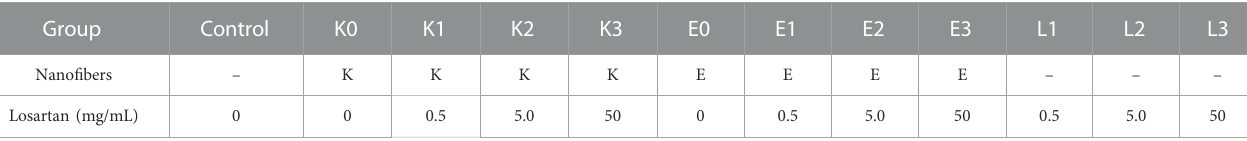
TABLE 1 Grouped by combination of losartan and nano fi bers.